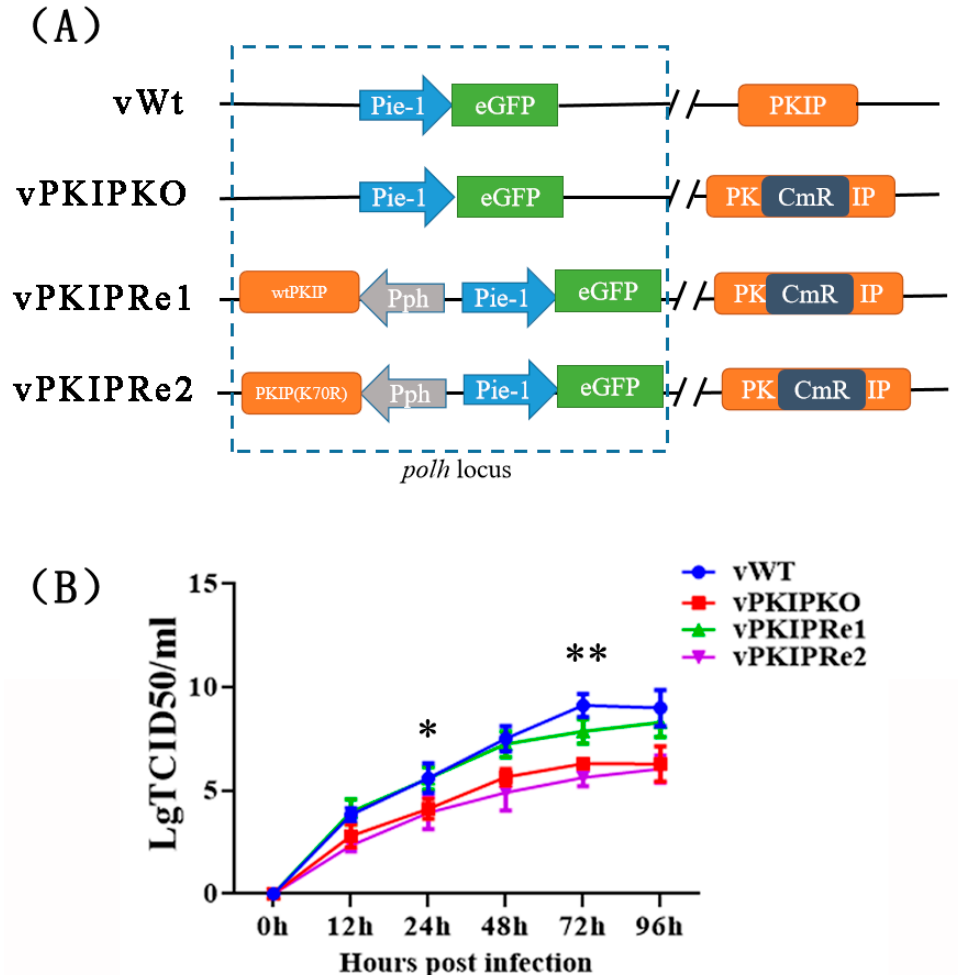
Figure 6. SUMOylation of PKIP is important to BmNPV replication. ( A ) Wild-type and mutant PKIP (K70R) were transformed to the polh locus of the PKIP-KO virus to generate different repair viruses. ( B ) The BV titer curves of each recombinant virus were determined. V Wt , virus without PKIP knockout; vPKIP, virus with PKIP knockout; vPKIPRe1, PKIP-knockout virus rescued with wild-type PKIP; vPKIPRe2, PKIP-knockout virus rescued with K70R-mutated PKIP. The error bars indicate the SDs of averages from three independent experiments with three technical replicates. Statistical analysis was applied with SPSS software. One-way ANOVA with Tukey’s post-test was used. Significant differences are indicated by asterisks (* p < 0.05; ** p < 0.01).